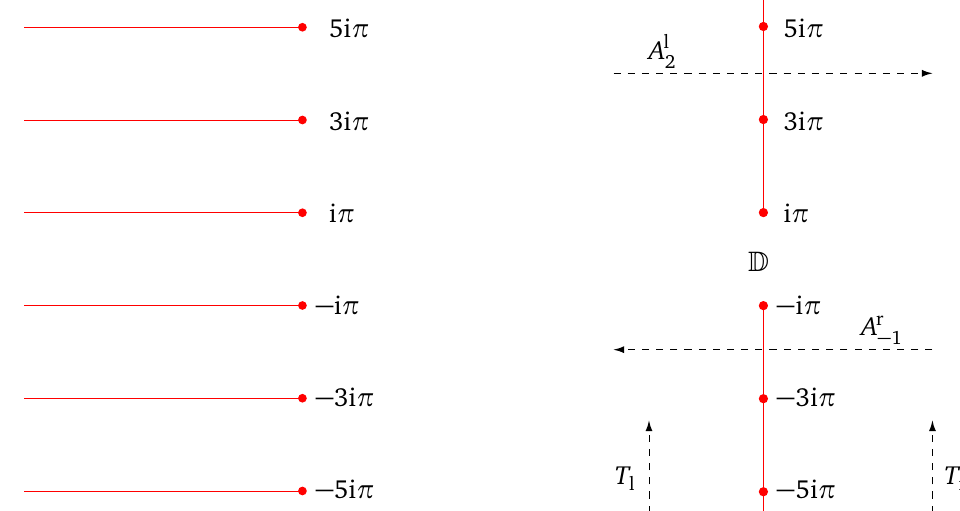
in (56), is 5 / 2 , l , A r , n ∈ (cid:90) defined in section 4.1 are n n